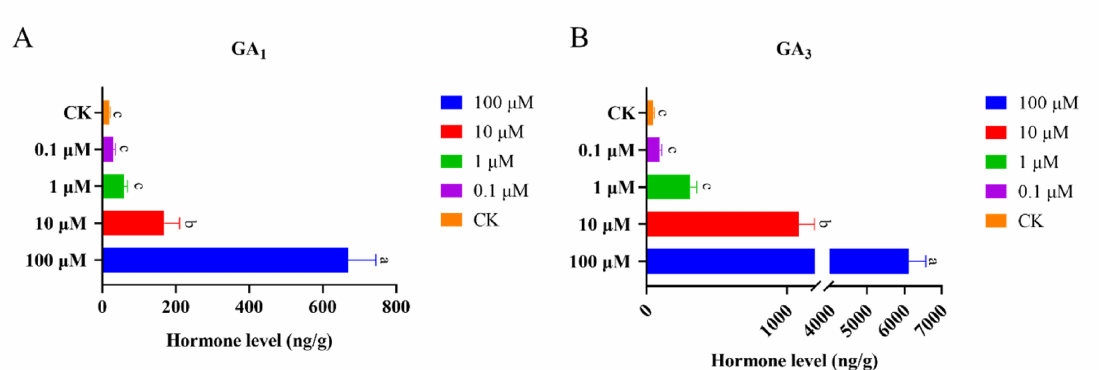
Figure 11. Endogenous GA 1 and GA 3 content changes in different concentration GA 3 treated soybean roots. ( A , B ) Content changes of GA 1 and GA 3 in the soybean cultivar Williams 82 roots treated with 0.1, 1, 10 and 100 µ M GA 3 . Multiple statistical comparisons between nematodes in control roots and GA treated roots were made by one-way analysis of variance (ANOVA) followed by LSD post hoc test. Different characters mean significant differences found at p < 0.05 level. Error bars represent standard deviation from the